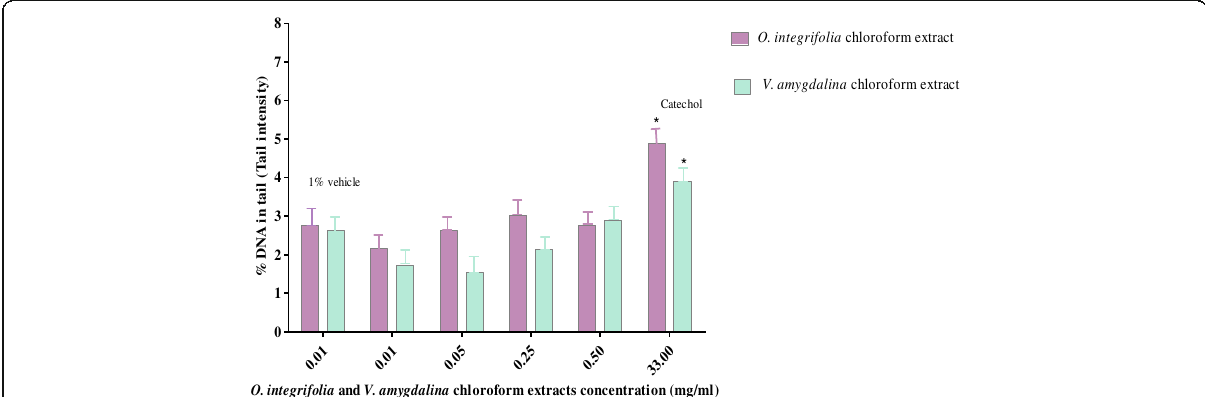
Fig. 3 Genotoxic effect of Otostegia integrifolia and V. amygdalina chloroform extracts on HepG 2 cells: cells were exposed for 3 h and DNA damage was monitored as an increase in percentage of DNA in the tail (tail intensity) after 10 min of electrophoresis in the comet assay. % vehicle=1% DMSO (negative control) and 3 mM catechol (positive control). The means of percentage of DNA in tail for at list three experiments were compared with the vehicle control using T-test for independent